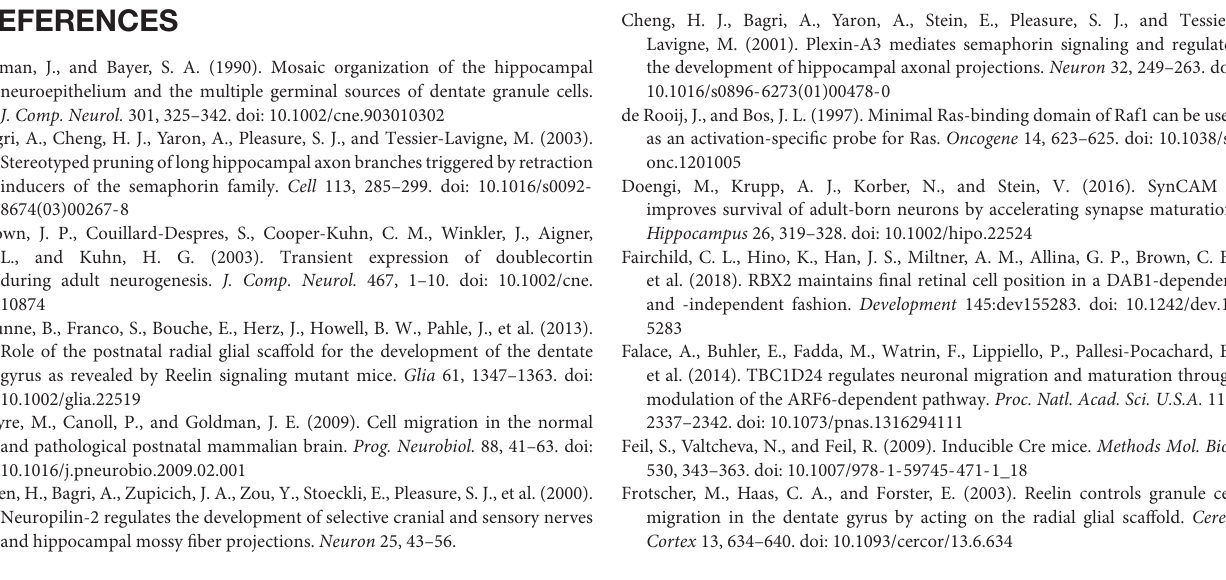
Supplementary Figure 1 | Defects in IPB pruning in RBX2 mutant DG are independent of age and Reelin/Dab1 and ARF6 signaling. (A) IPB overextension in the RBX2cKO-Emx1 mice remains in adult mice (P75). Similar to P21 results, CalB stainings of control and RBX2cKO-Emx1 DG showed an ectopically IPB extension only in the RBX2 mutant DG. Arrows and arrowheads demarcate SPB and IPB extension, respectively. (B) SOCS7 depletion, which causes a sustained activation